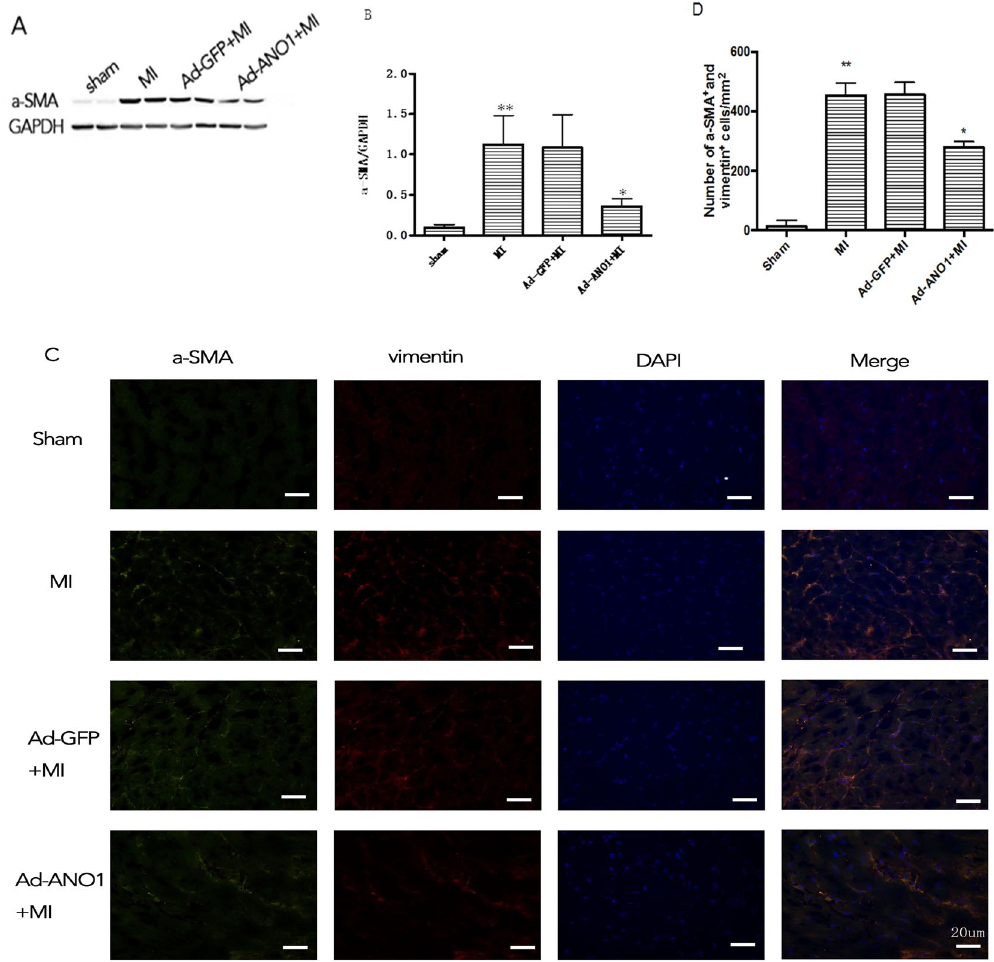
Figure 6. ANO1 inhibited myofibroblast differentiation in vivo. ( A ) Western blot of a-SMA protein expression. GAPDH was used as loading controls. ( B ) Quantitative analysis of a-SMA. ( C )Representative immunofluorescence image of a-SMA and vimentin, green, a-SMA; red,vimentin; blue, nuclei. Scale bars represent 20 μ m. ( D ) The quantification of number of a-SMA and vimentin positivestaining cells per mm2. * p < 0.05 versus MI or Ad-GFP + MI, ** p < 0.01 versus sham (n =